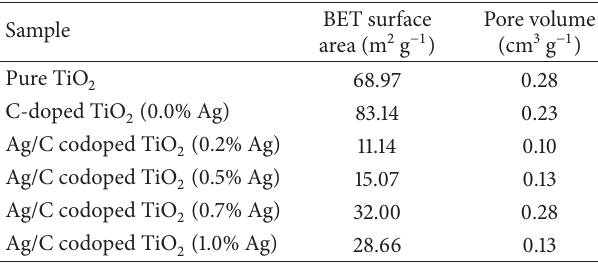
a nitrogen environment. The thermograms showing the per- Figure